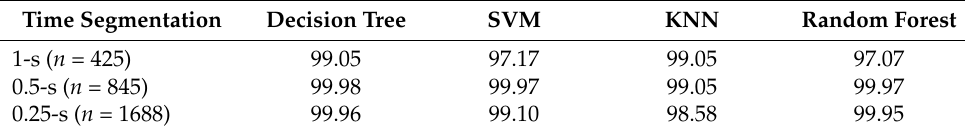
Table 4. Classification testing accuracy (%) of machine learning models.